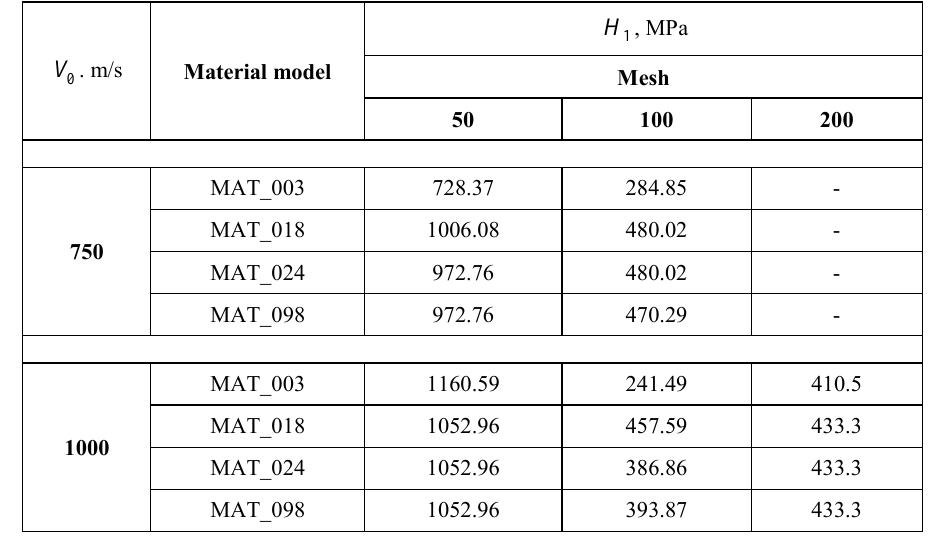
Table 2. The calculated values of dynamic hardness for various speeds, mesh size and type of material (the